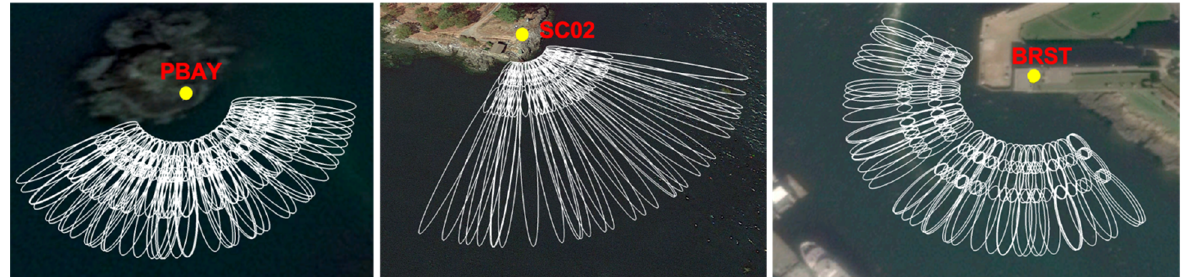
Figure A2. Locations of the three GNSS stations PBAY, SC02 and BRST (yellow dots), and the corresponding reflection areas (white ellipses), which were approximated by the first Fresnel zone for a reflector height of 6 m for PBAY, 5 m for SC02 and 16 m for BRST. The white ellipses for each satellite track are the sensing zones for GPS observations for elevation angles 12 ◦ (longest ellipse), 20 ◦ (second ellipse) and 25 ◦ (shortest ellipse) for PBAY, for elevation angles 5 ◦ (longest ellipse), 10 ◦ (second ellipse), and 15 ◦ (shortest ellipse) for SC02, and for elevation angles 15 ◦ (longest ellipse), 20 ◦ (second ellipse), and 15 ◦ (shortest ellipse) for BRST. We made the figures using Google Earth. PBAY was equipped with TRM57971.00 antenna and SCIT radome without equipment change from 2012 to 2020. SC02 was equipped with TRM29659.00 antenna and SCIT radome from 2011 to 29 April 2015, and afterward changed to TRM59800.80. BRST was initially equipped with LEIAT504GG antenna, and changed to LEIAT504GG antenna on 11 June 2008, and TRM57971.00 antenna on 16 October 2011.